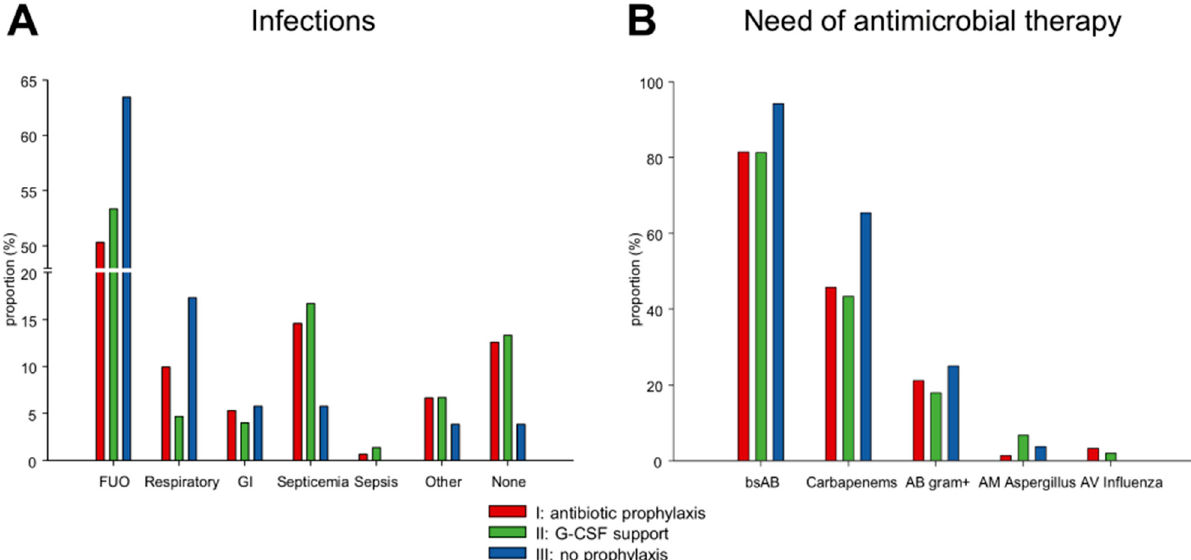
Figure 1. Frequency distribution of ( A ) infections and ( B ) administered antimicrobial therapies during the inpatient stay in the three groups of anti-infective strategy. Abbreviations: AB, antibiotics; AM, antimycotics; AV, antivirals; bsAB, broad-spectrum antibiotics; FUO, fever of unknown origin; GI, gastrointestinal.